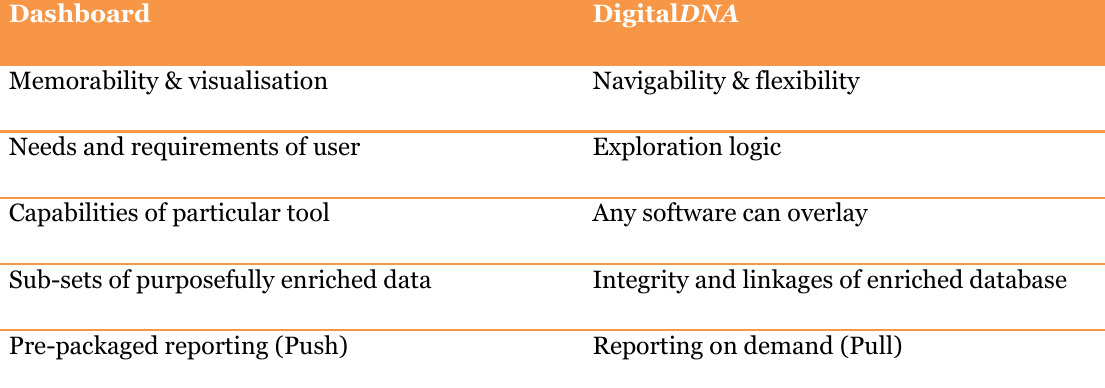
Shifts from Dashboards to DigitalDNA